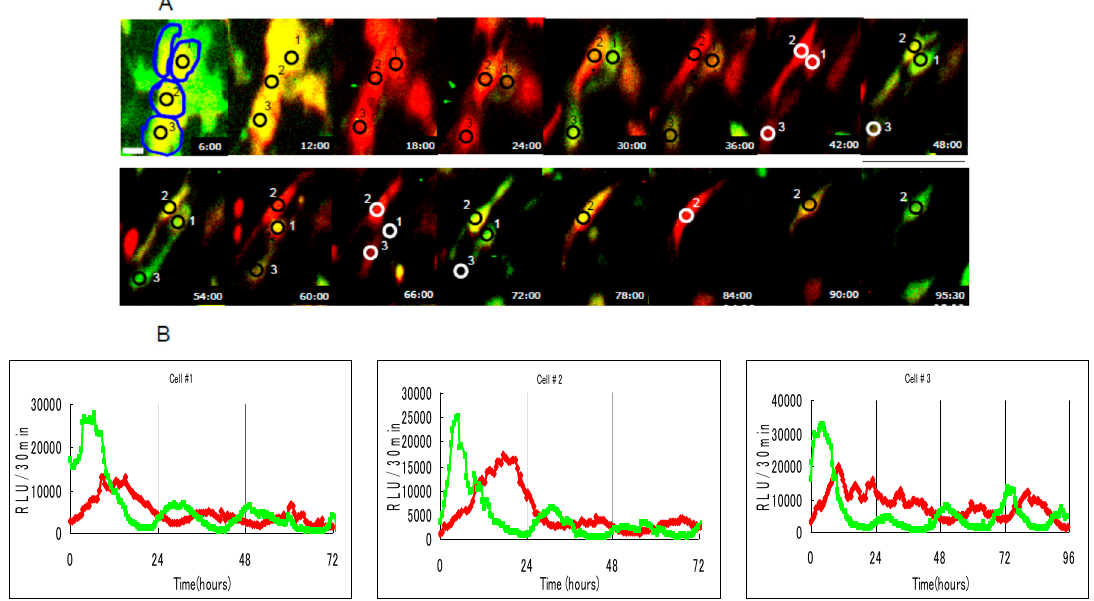
Figure 1. Bioluminescence imaging of dual gene expression at the single-cell level. ( A ) The dual-color bioluminescence imaging of NIH3T3 cells cotransfected with the Bmal1-red luciferase plasmid (red) and the Per2-green luciferase plasmid (green), showing circadian rhythms of green and red luminescence, respectively. Each spot is on a separate cell. Scale bar, 20 μ m; ( B ) Representative circadian bioluminescence rhythms from individual NIH3T3 cells cotransfected with Bmal1-pSLR plasmid (red) and Per2-pEluc plasmid (green) for 3–4 days. Each graph represents real-time analysis data of quantitative bioluminescence intensity for the respective spot shown in Figure 1A. Reproduced with permission from [25].